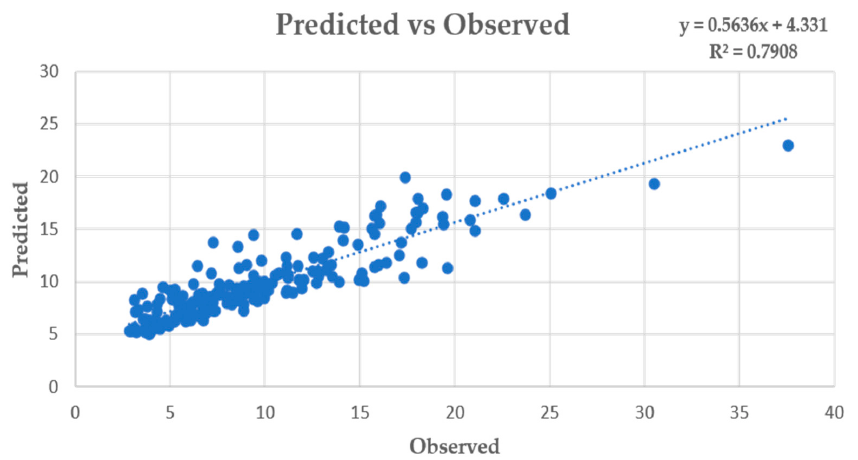
Figure 7. Random forest regression, predicted canopy heights vs. observed values from GEDI.